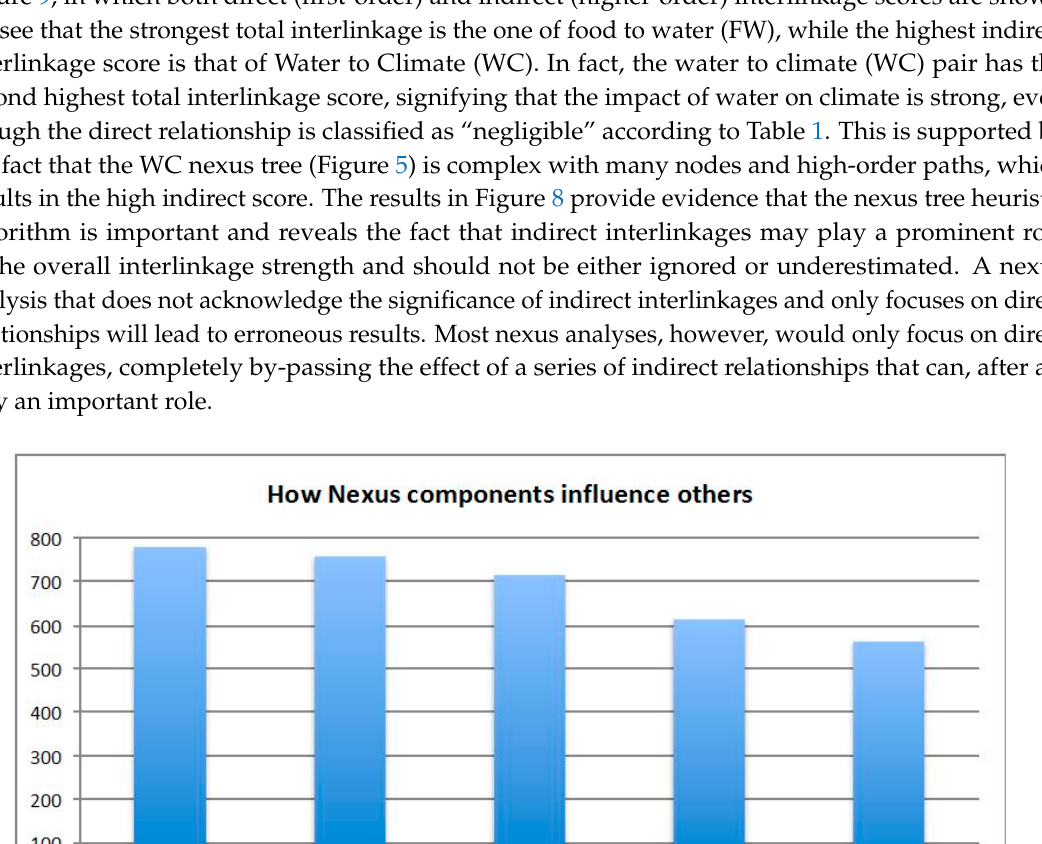
Figure 6. Cross-interlinkage matrix of five nexus components and their interactions for Greece. The total strength of interlinkage from a nexus component on all other nexus components is shown by the row-sum and the column-sum shows how much a nexus component is influenced by all other nexus components in total. Highest row- and column-sums are marked in green. W = Water; E = Energy; F = Food; L = Land Use; C = Climate.